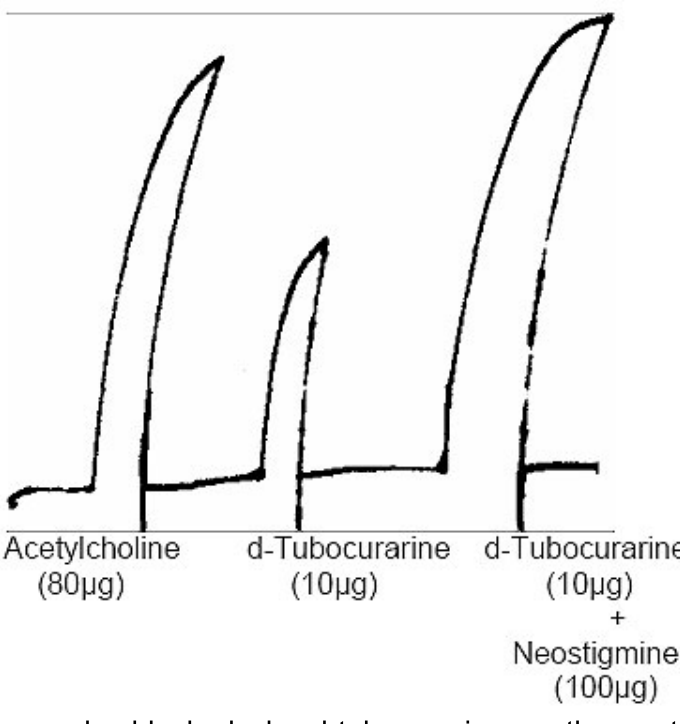
value of 160µg/kg mice. 50